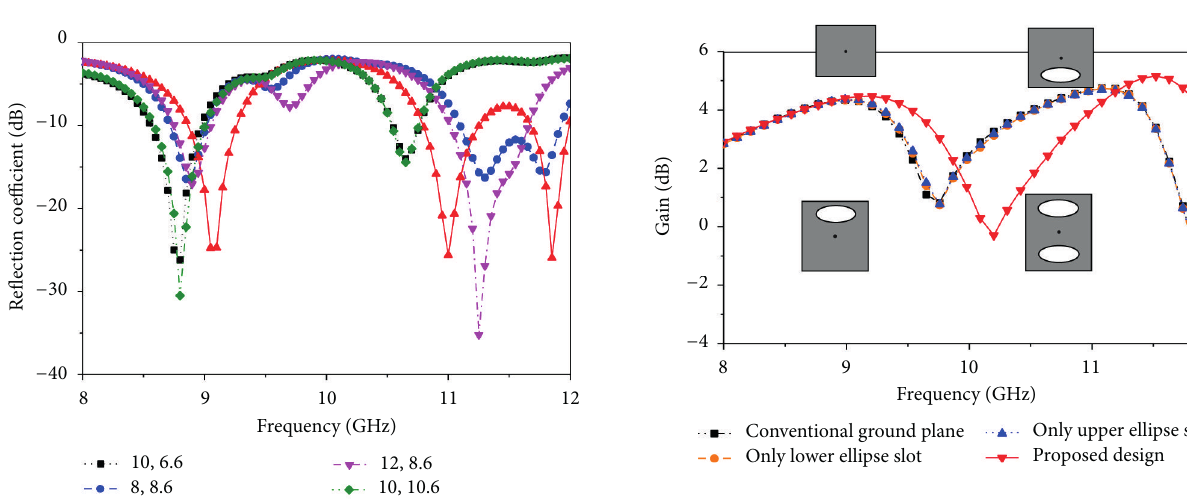
Figure 8: Simulated peak gain for the effect of ground plane modification (other parameters: 𝐿 = 20 mm, 𝑊 = 17.2 mm, 𝐿1 = 3 mm, 𝐿2 = 13 mm, 𝐿 = 17.2 mm, 𝑅1 = 2 mm, 𝑅2 = 3 mm, 𝑋 𝑊 𝑔